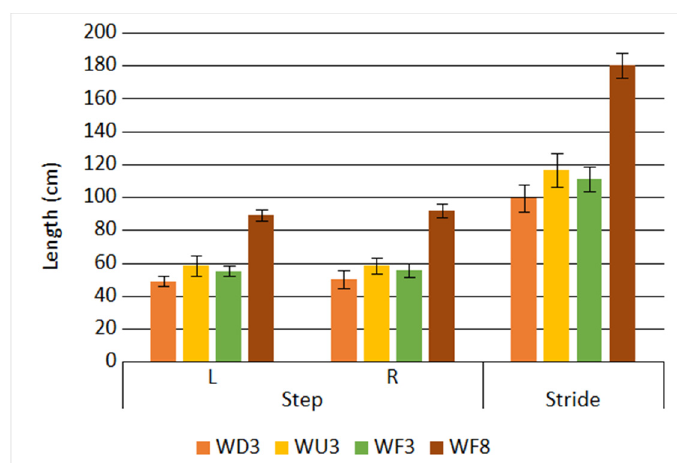
Figure 15. Step and stride during physical activities.